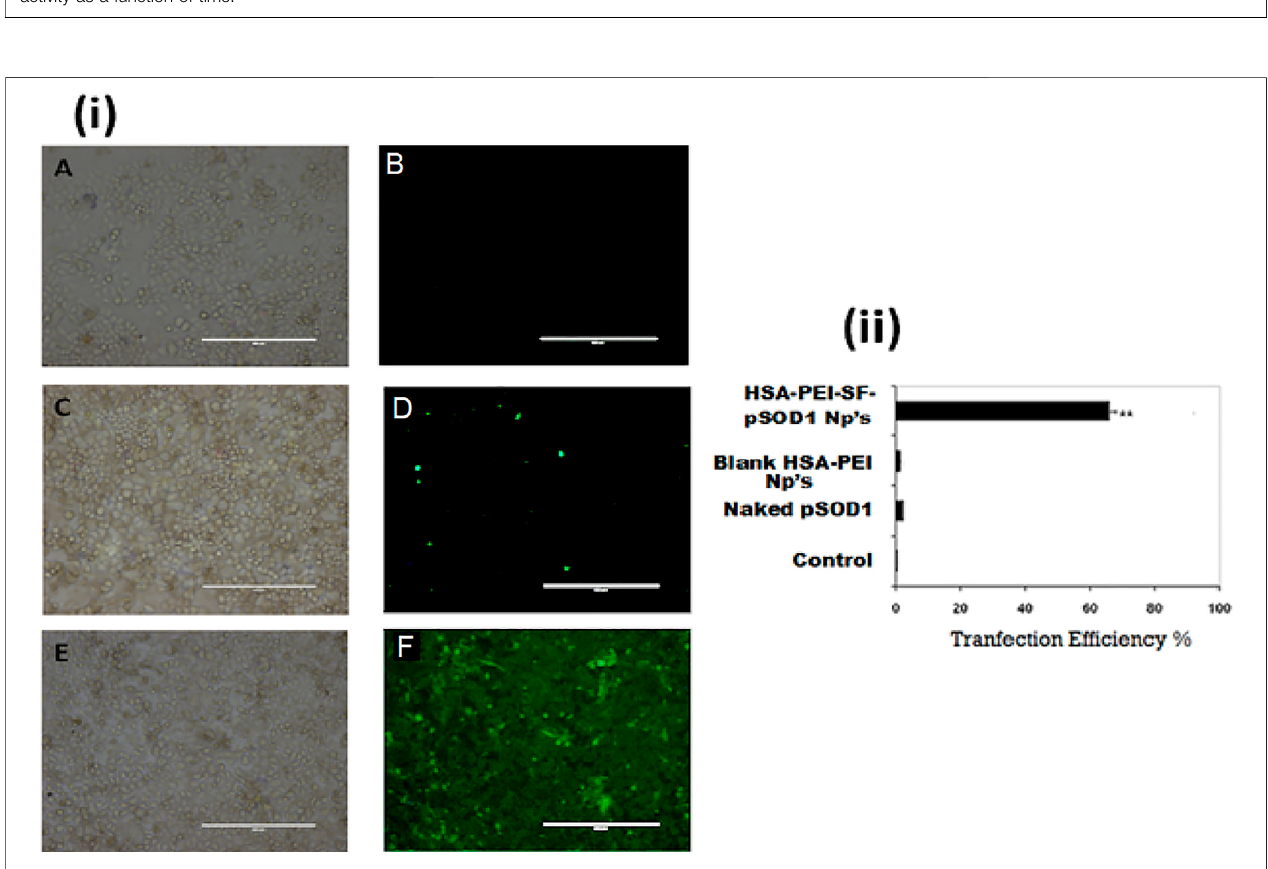
FIGURE 5 | The HSA nanoparticles allow ef fi cient in vitro gene transfection and expression of pSOD1 in L-132 cells. (i) (A,B) : in vitro transfection ef fi ciency with blank HSA-PEI Np ’ s only; (C,D) : transfected with 5000 ng pSOD1 only; (E,F) : HSA-PEI-SF-pSOD1 Np ’ s containing 460 ng pSOD1 following 6 h incubation; transfection was assessed at 48 h post-transfection. Data are expressed as mean ± SD for n = 3. ** Indicates a signi fi cant difference from the control group at p ≤ 0.01.